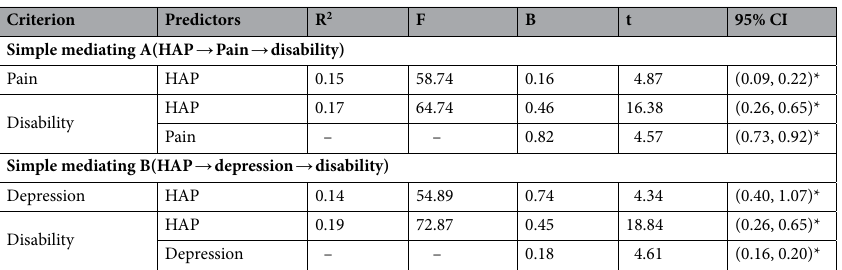
Table 4. Regression coefficients in the simple mediation model analysis (N = 5471). *Significant mediator (i.e., zero is not contained within the confidence intervals); sex, age, residence, Hukou, education level, marital status, income, chronic disease status, smoking status, and drinking status were analyzed as control